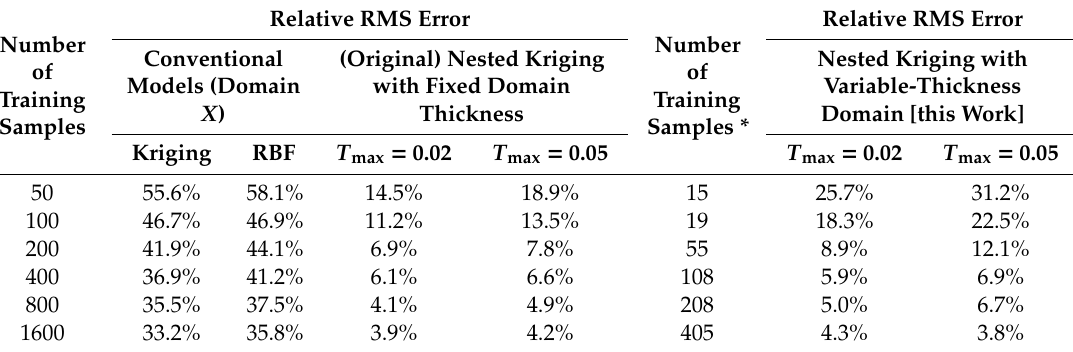
Figure 7. Allocation of the reference designs for the dual-band antenna of Figure 6: ( a ) objective space, ( b ) selected three-dimensional projections of the parameter space. Table 1. Modeling Results for Antenna of Figure